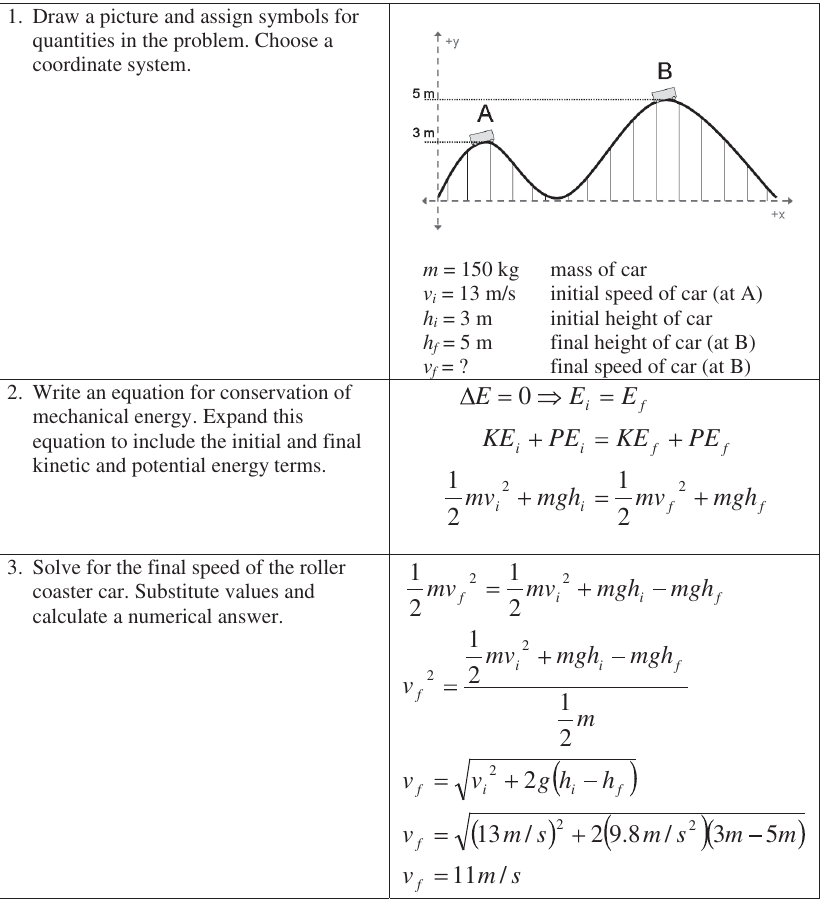
FIG. 2. Sample two-column